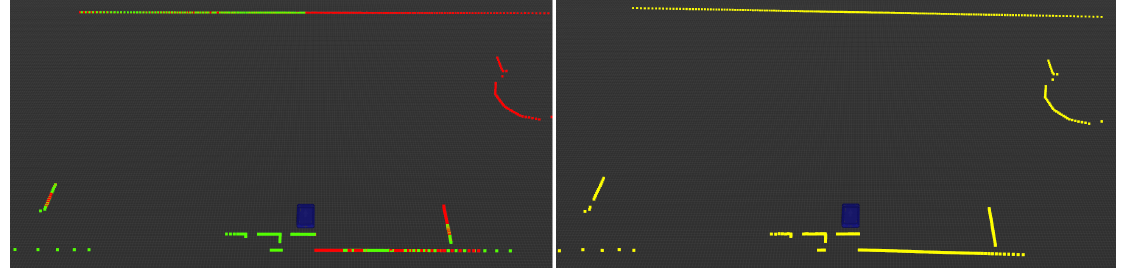
Figure 8. The signals from both front and rear scanner ( left ), and the final output 360 ◦ environment scan ( right